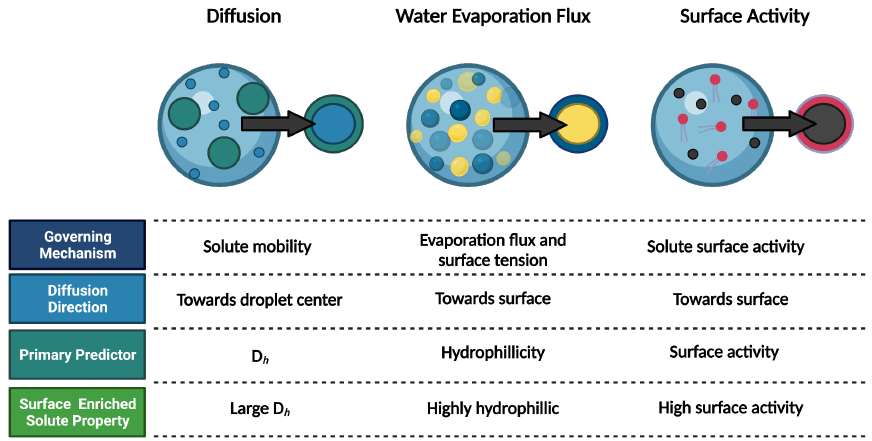
Figure 1. Component distribution in spray dried particles is governed by diffusion, water evaporation flux, and surface activity driven evaporation induced self assembly